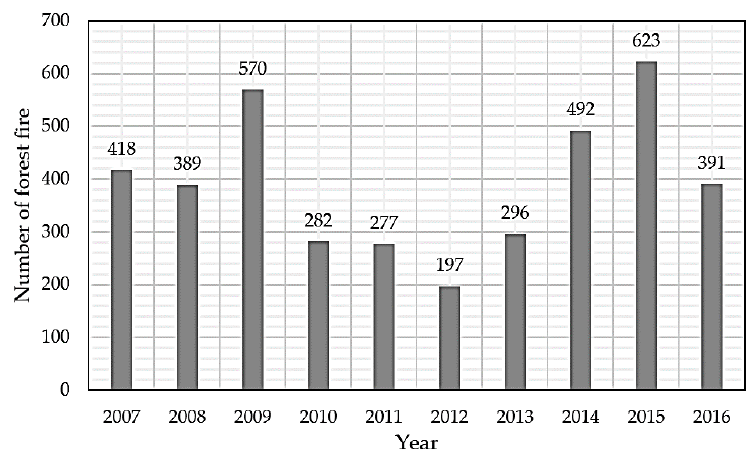
Figure 1. South Korea total yearly forest fires.